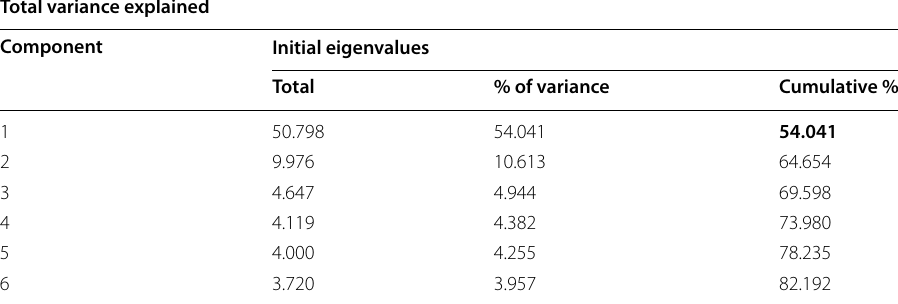
Table 5 The highest components of PCA for the second runs Total variance explained Component Initial eigenvalues Total % of variance Cumulative